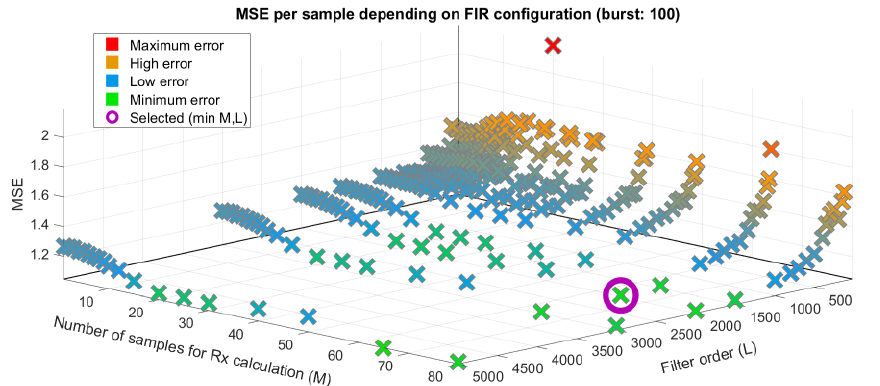
Figure 9. Mean square error (MSE) per sample of the FIR method depending on the FIR order ( L ) and the number of samples used in the auto-correlation calculation ( M